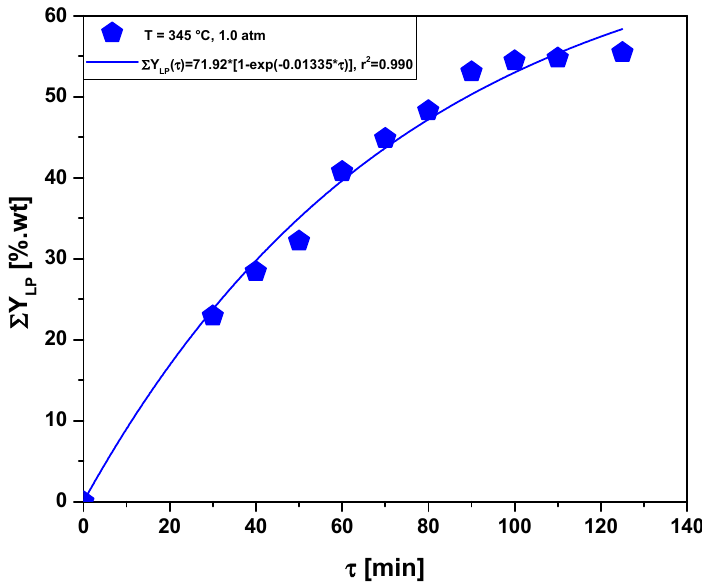
Figure 7. Cumulative yield of reaction liquid products by depolymerization of PMMA based dental resins fragments/residues at 345 °C, atmospheric pressure, in pilot scale.